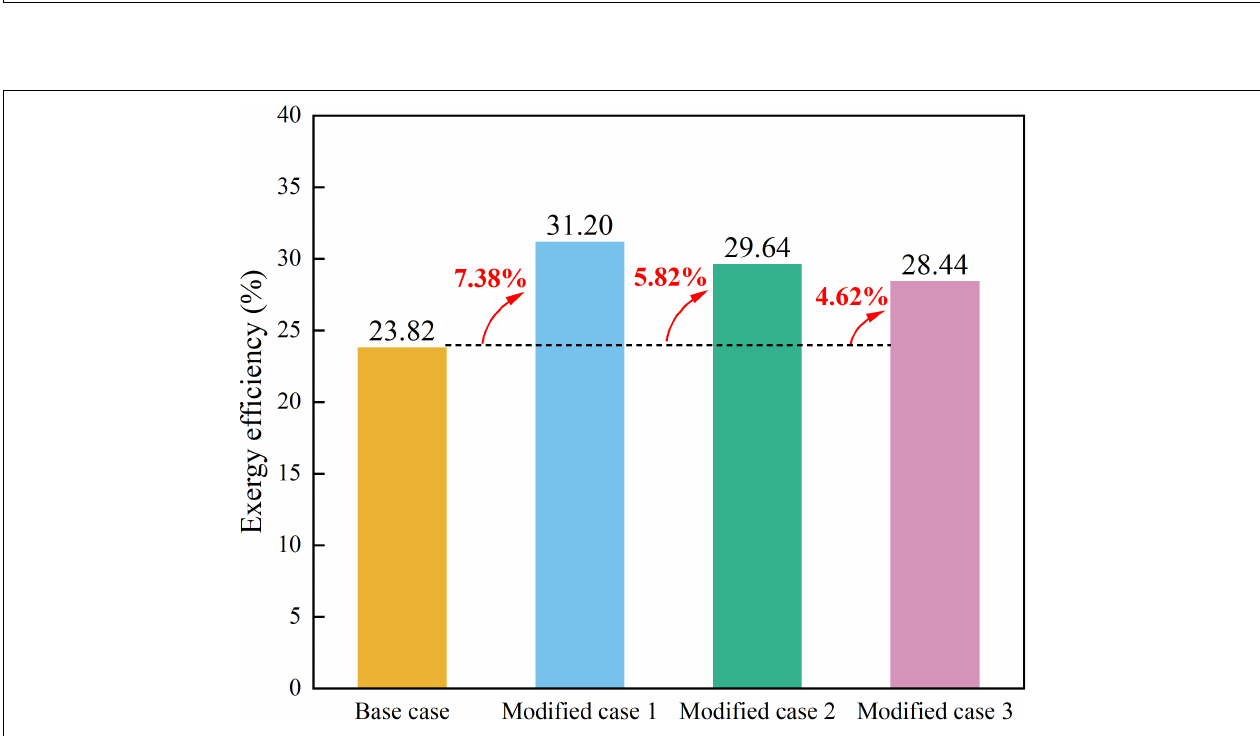
FIGURE 6 | TDCC of four cases: (A) Base case; (B) modified case 1; (C) modified case 2; (D) modified case 3.